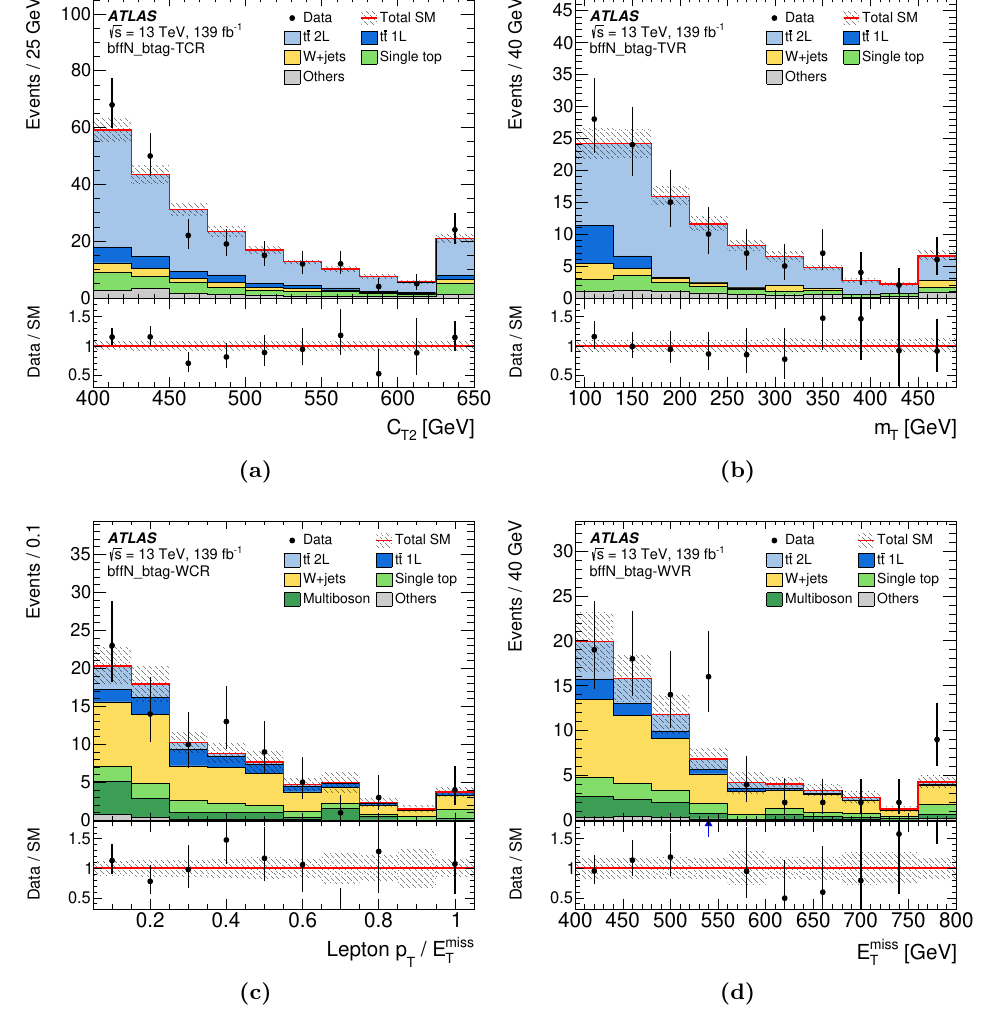
Figure 9. Selected kinematic distributions in bffN_btag CRs and VRs: (a) C T2 in the TCR, (b) m T in the TVR, (c) p ‘ /E miss in the WCR, (d) E miss in the WVR. The distributions shown are T T T post-fit, i.e. each background is scaled by a normalisation factor obtained from a background-only likelihood fit to the CRs (see table 14). The hatched area around the total SM prediction and the hatched band in the Data/SM ratio include all statistical and systematic uncertainties. The last (first) bin contains overflows